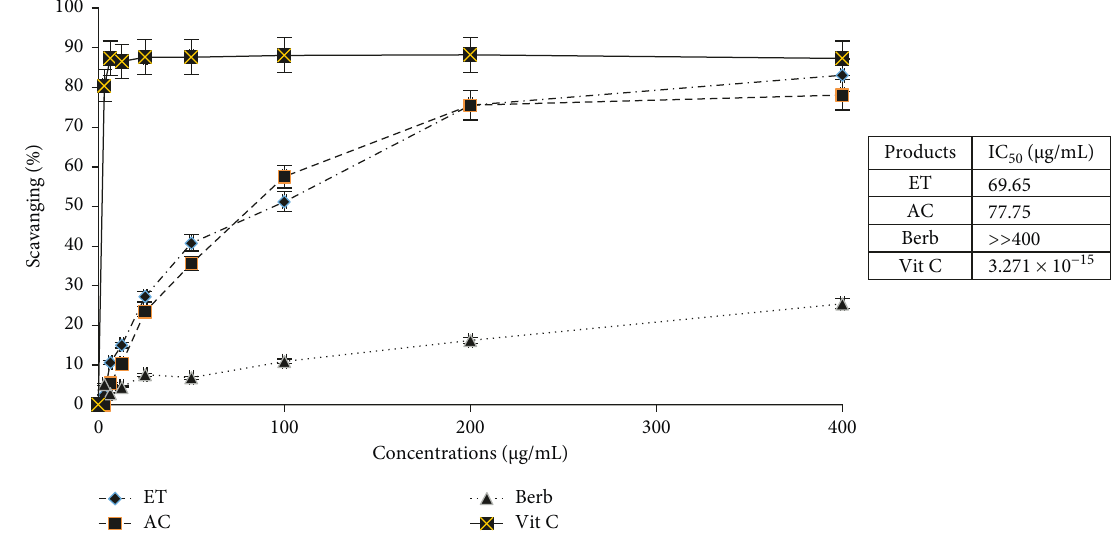
Figure 5: In vitro antioxidant effect of berberine and Berberis vulgaris extracts. ET: ethanol extract, AC: ethyl acetate extract, Berb: berberine, Vit C: vitamin